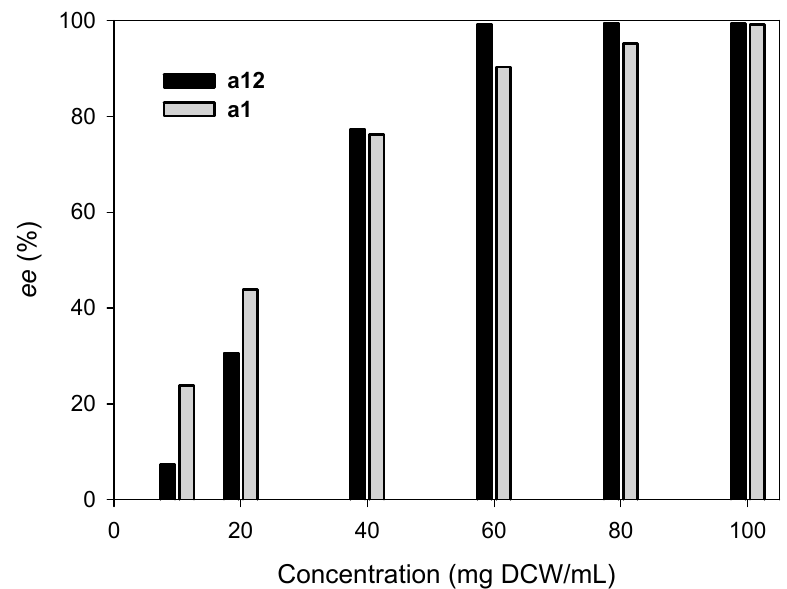
Figure 8. The effect of the amount of whole-cell on the kinetic resolution of 50 mM a12 or 20 mM a1 . Reaction conditions: 100 mM Tris/HCl buffer (pH 8.5), 50 mM a12 (or 20 mM a1 ), and whole-cell (10–100 mg DCW/mL).